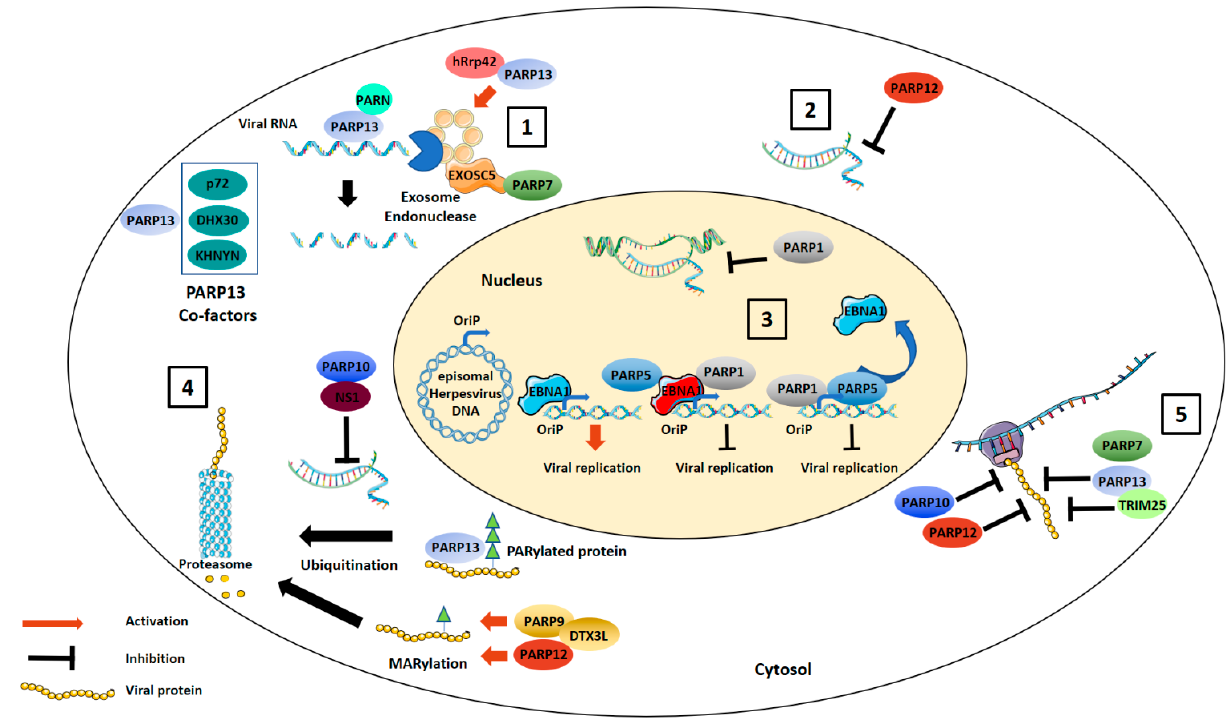
Figure 1. Direct antiviral activities of PARPs. PARP13 and PARP7 can induce exosome-mediated degradation of target viral RNAs ( 1 ). PARPs can also inhibit viral genome replication. PARP12 inhibits viral RNA transcription within the cell cytoplasm ( 2 ). PARP1 or PARP5 PARylate or directly interact with EBNA1, preventing EBNA1 binding to the OriP promoter and inhibiting Epstein–Barr virus (EBV) replication ( 3 ). PARPs directly interact with viral proteins. PARP9/DTX3L complex and PARP12 catalyze mono-ADP-ribosylation (MARylation) of viral proteins leading to their proteosomal degradation while PARP10, through binding to avian influenza virus NS1, prevents viral RNA replication. PARP13 binds already PARylated influenza A virus proteins leading to their proteosomal degradation ( 4 ). Finally, PARP7, -10, -12 and -13 are inhibitors of viral translation stopping the formation of the translation initiation complex on viral mRNA ( 5